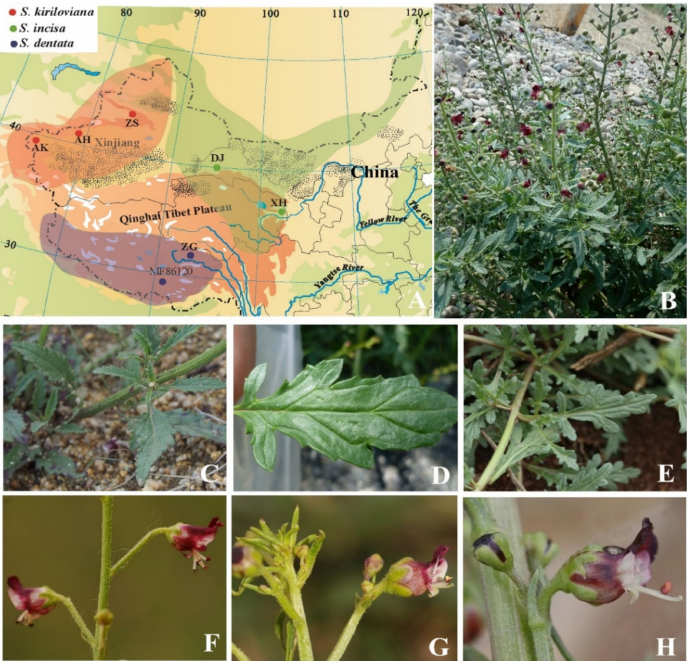
Figure 1. Distribution map and morphological characters of S. incisa complex. ( A ) Distribution map of S. incisa complex. ( B ) Morphology and habitat of S. incisa . ( C – E ) Leaves of S. incisa , S. kiriloviana and S. dentata . ( F – H ) Flowers of S. incisa , S. kiriloviana and S. dentata (Photo ( B ): by Chong-Lie Qu, ( C ): by Guo-Jun Hua, ( D , G ): by Pan Li, ( E ): by Xin-Xin Zhu, ( F ): Jian-Bin Pan, ( H ): by Po-Po